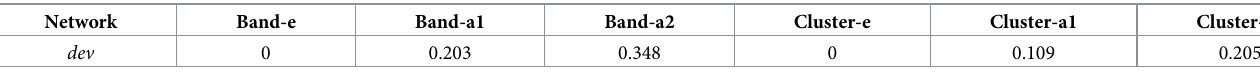
Table 1. Deviations from the exchangeable condition under different scenarios.